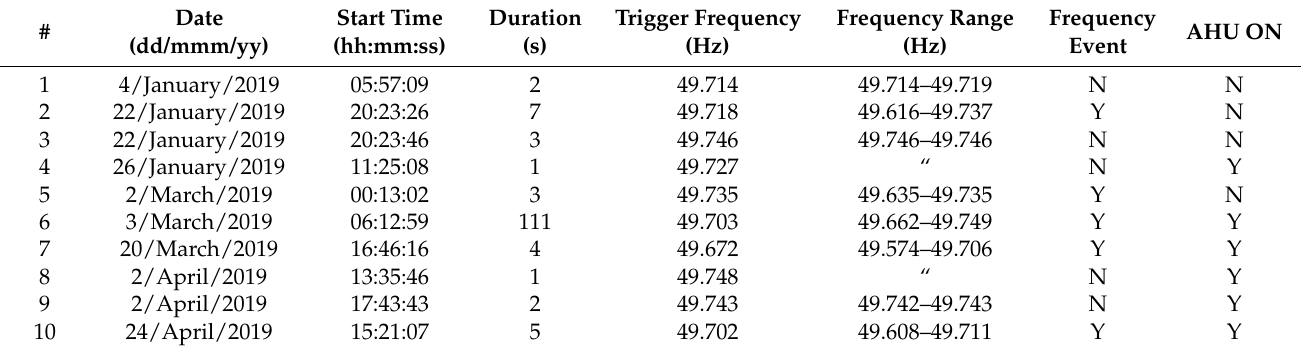
Table A1. Overview of events where the grid frequency dropped below 49.75 Hz during the years 2019 and